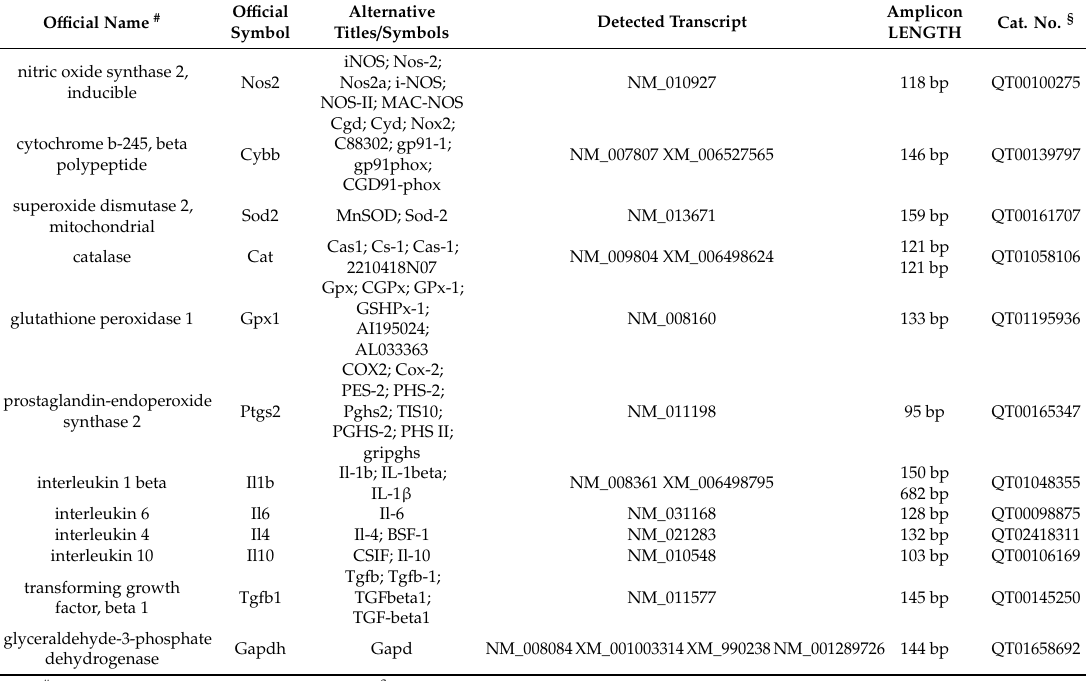
Table 1. The list of primers used for quantitative real-time PCR